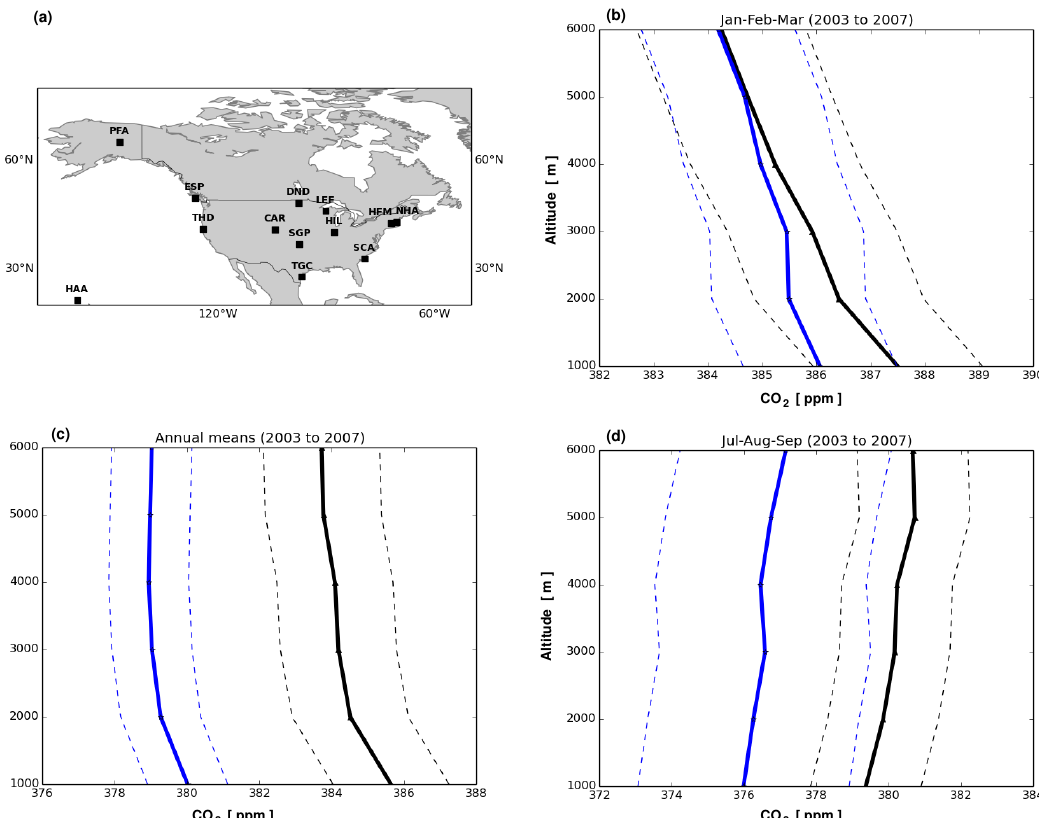
Figure 14. (a) Map of sites from the NOAA/ESRL GMD Carbon Cycle Vertical Profile Network used in the evaluation of the model CO 2 vertical profiles and (b, c, d) Average profiles of CO 2 dry molar fraction [ppm] observed by NOAA/ESRL GMD Carbon Cycle Vertical Profile Network (Tans et al., 1996) in black and CO 2 hindcast in blue from 2003 to 2007 for January to March, January to December and July to September respectively. The average profiles plus/minus their standard deviation are shown as dashed